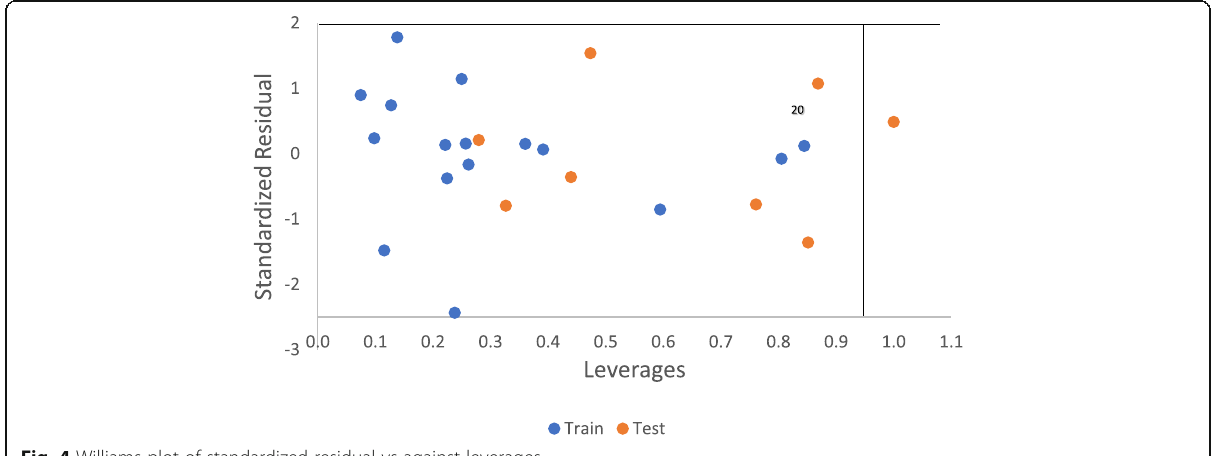
Fig. 4 Williams plot of standardized residual vs against leverages